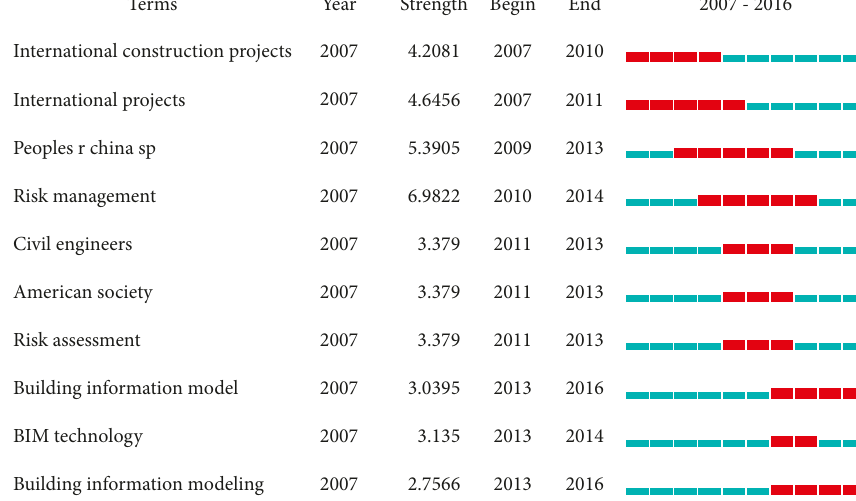
Figure 6: Keyword burst